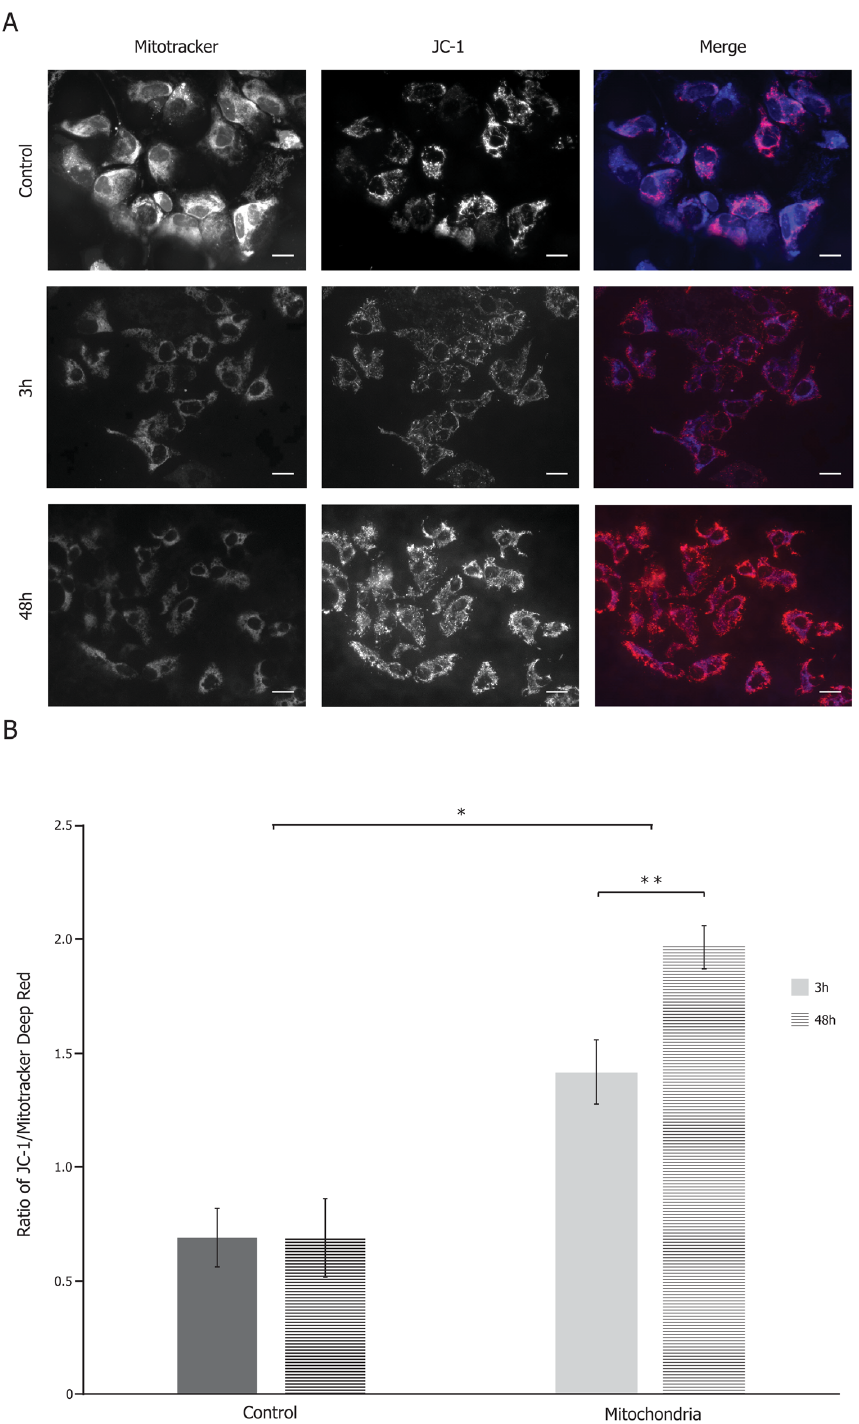
Figure 2. Mitochondria internalization improves mitochondrial membrane potential (ΔΨ) in FECD cells. ( A ) A marker of ΔΨ (JC-1, red) was used in conjunction with a mitochondrial mass marker (mitotracker; blue) for all FECD explants of this experiment, exposed to exogenous mitochondria or not (Control) for 3 h or 48 h. ( B ) Ratio of ΔΨ/mitochondrial mass (JC-1 on mitotracker) is higher in the explants exposed to exogenous mitochondria than in the controls. This increase is statistically significantly more pronounced at 48 h than at 3 h. Scale bar = 40 µm. Serial measurements at each time point were performed on 4 explants from 4 FECD patients (47 microscope fields analyzed at 3 h; 41 fields at 48 h). *p < 0.005; **p <